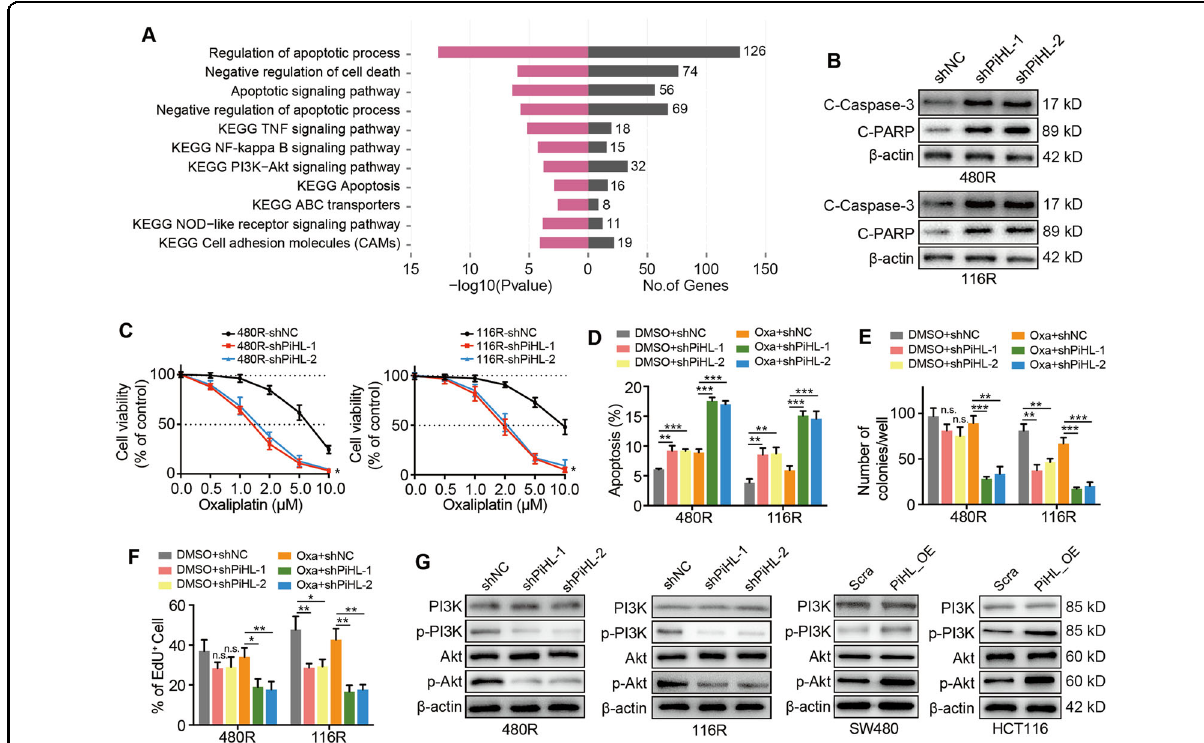
Fig. 3 Knockdown of PiHL restores oxaliplatin sensitivity in Oxa-resistant CRC cells in vitro. A – Log10 transformations of the P -values of top 11 signi fi cantly enriched pathways by PiHL knockdown. B Expression of cleaved Caspase-3 (C-Caspase-3) and cleaved PARP (C-PARP) in PiHL silencing Oxa-resistant CRC cells after 5 μ M oxaliplatin treatment for 72 h were analyzed by western blotting. C Effect of PiHL knockdown on Oxa-resistant cells with oxaliplatin treatment at the indicated concentrations for 72 h was analyzed by CCK-8 assay. D Flow cytometric analysis revealing the effect of PiHL knockdown on apoptosis of Oxa-resistant cells with oxaliplatin treatment (5 μ M) for 72 h. E Colony formation of Oxa-resistant cells with PiHL knockdown under oxaliplatin treatment (5 μ M) for 72 h. The average number of colonies is shown. F EdU assay showing the effect of PiHL knockdown on DNA replication activity of Oxa-resistant cells with oxaliplatin treatment (5 μ M) for 72 h. G Western blot analysis of indicated proteins in Oxa-resistant and parental CRC cells with PiHL knockdown, PiHL overexpression, or controls. Data are presented as the mean ± SD. P- value was determined by Student ’ s t -test or one-way ANOVA. Signi fi cant results were presented as n.s. non-signi fi cant or * P < 0.05, ** P < 0.01, *** P <